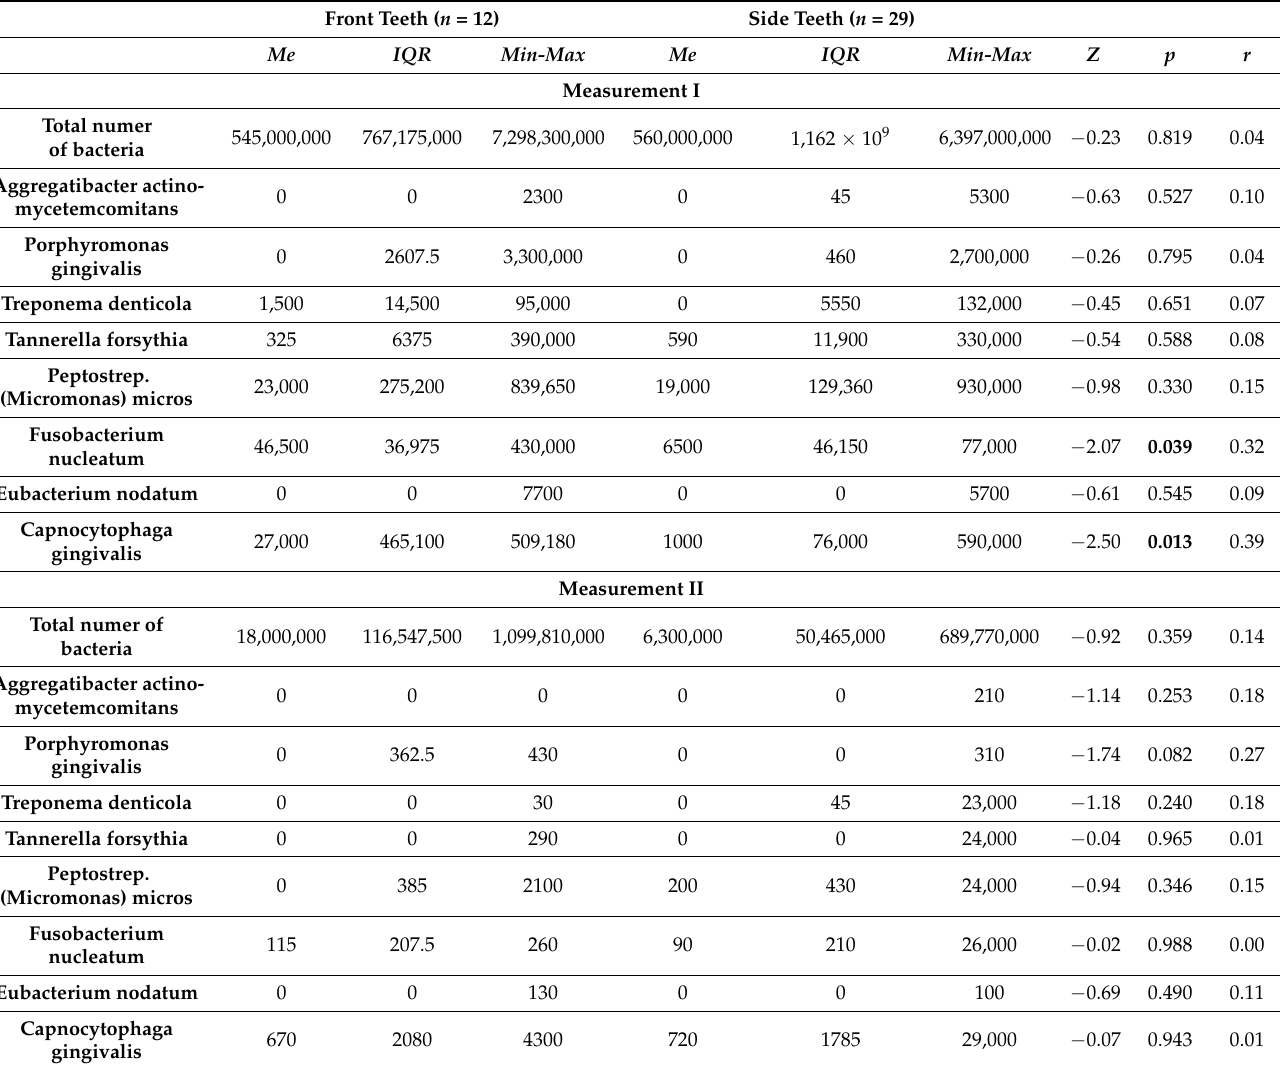
Table 6. Number of bacteria detected in peri-implant soft tissues of patients, depending on the position of the implant, before (measurement I) and after treatment (measurement II) with a bioactive healing abutment containing